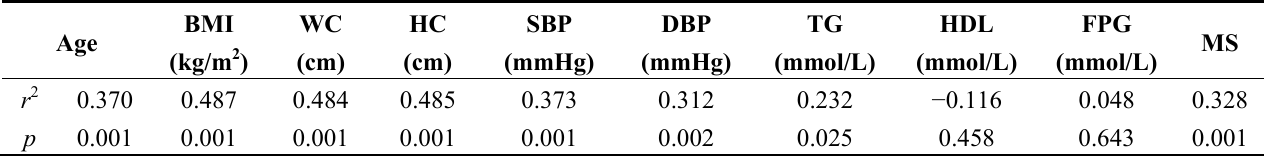
Table 3. Relationship between clinical features and carotid intima-media thickness (IMT) in Children from